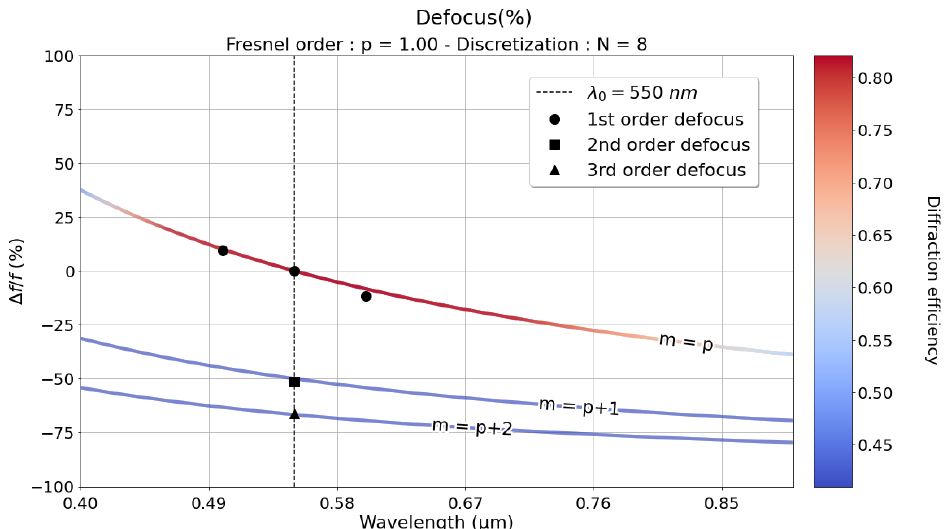
Figure 11. Focal length shift ∆ f/f as a function of the wavelength for different orders of diffraction. Note that for the orders p + 1 and p + 2, the efficiency is not sufficient to see clearly the focal shift as a function of wavelength.